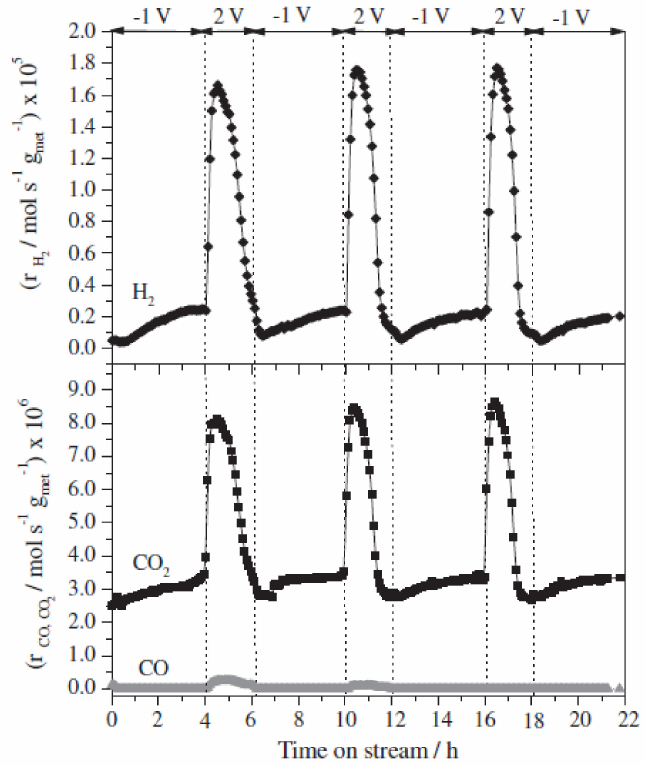
Figure 5. H 2 , CO and CO 2 molar flow rates vs. time during a cycling deactivation / regeneration experiment witha Pt-YSZ / Na + - β ”Al 2 O 3 electrochemicalcatalyst. Fixed methaneautothermal reforming reaction conditions: 1% CH 4 , 4% H 2 O, 0.2% O 2 (N 2 balance), 500 ◦ C. Catalyst deactivation step: + 2 V. Catalyst regeneration step: − 1 V. Reprinted with permission from